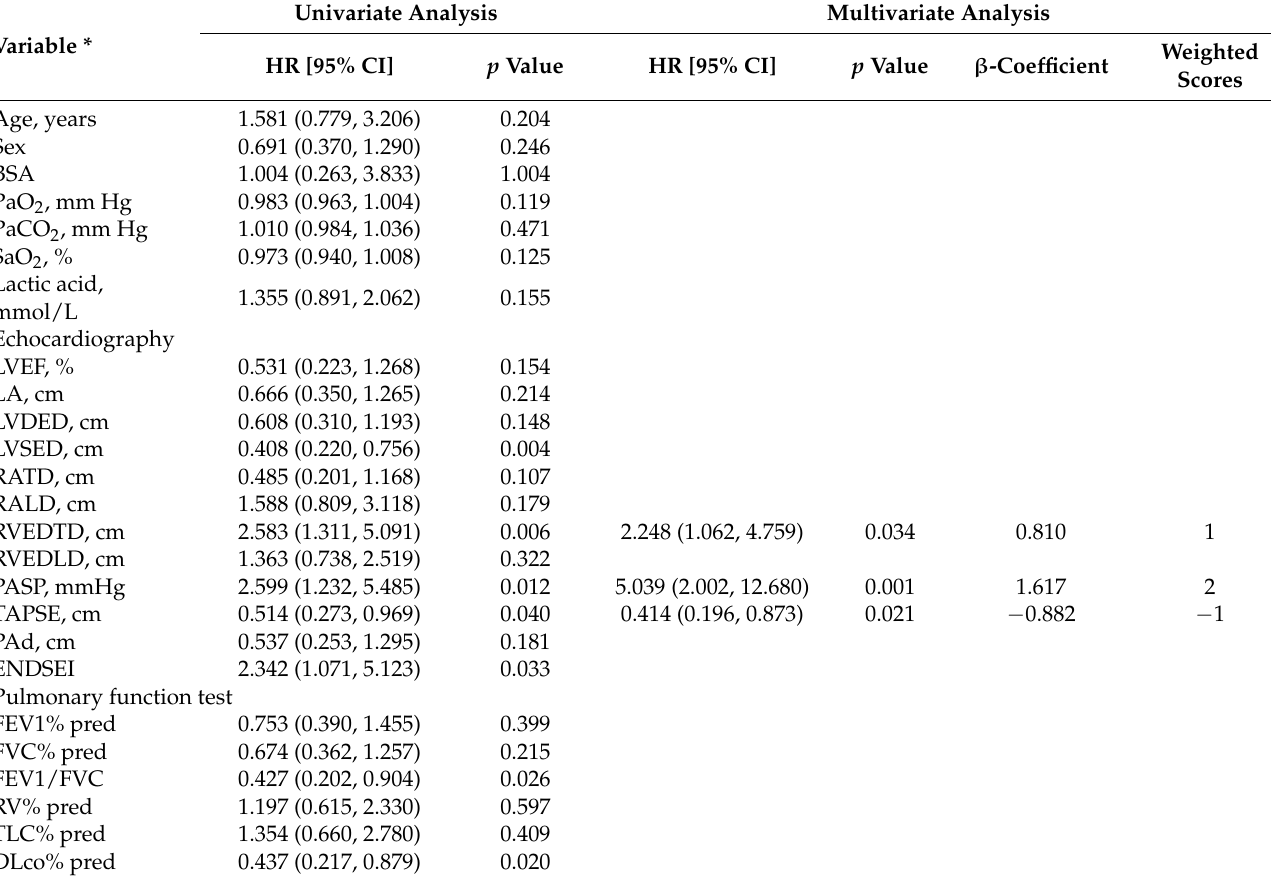
Table 2. Cox univariate and multivariate regression analyses for all-cause mortality in the deriva- tion